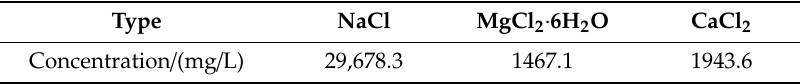
Table 2. Composition of the simulated formation water from the CQ